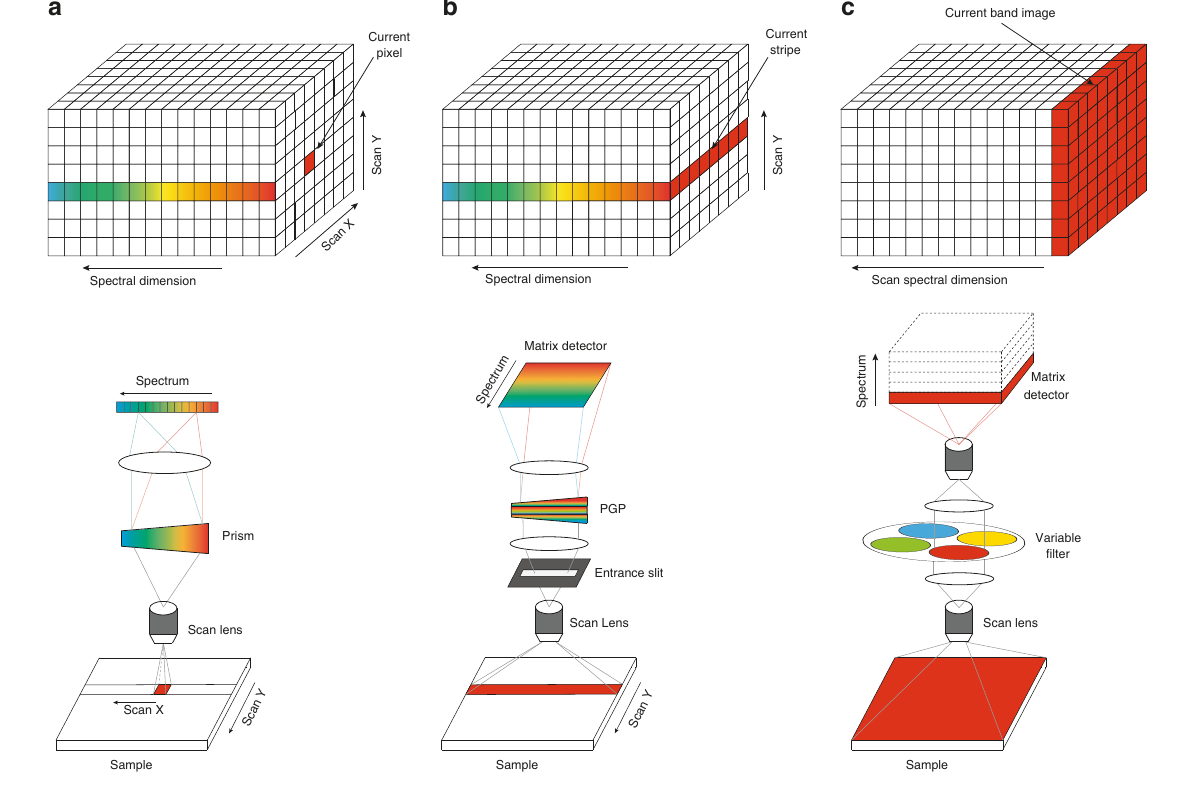
Fig. 1 Typical scanning spectral imaging approaches. a Whiskbroom. b Pushbroom. PGP prism-grating-prism. c Wavelength